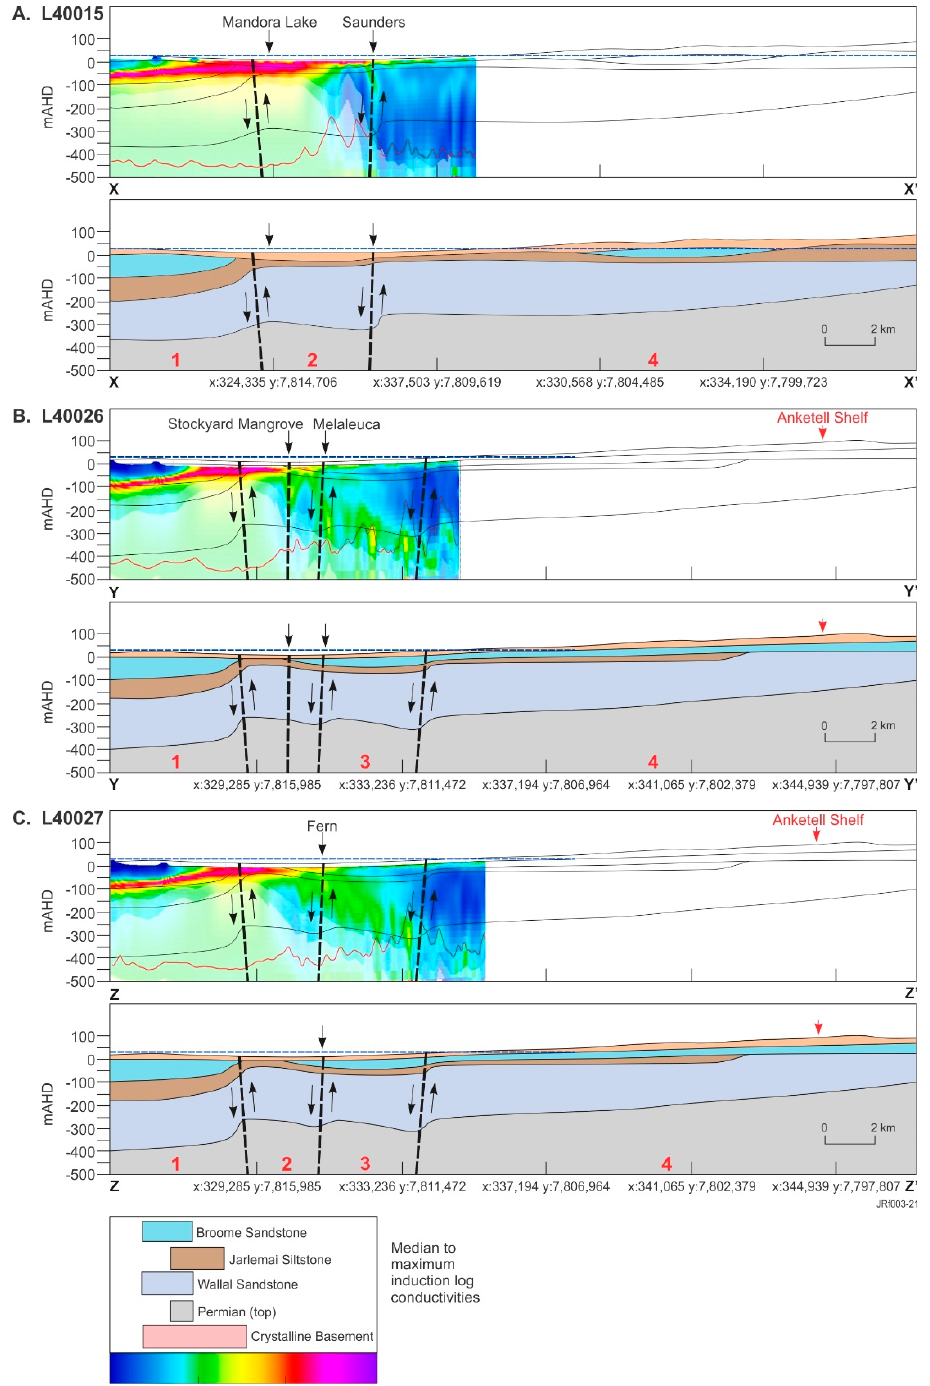
Figure 5. TEMPEST AEM 1D spatially constrained inversion (SCI) pseudo-colored conductivity depth sections (2020) for flight lines ( A ) L40015, ( B ) L40026 and ( C ) L40027 (west to east; see Figure 4 for location) (grey shading represents depth of investigation (DOI), and red linework, the 1D AEM inversion error; to the left, conductivity depth sections are superimposed on respective northwest trending geological cross-sections (X-X’, Y-Y’ and Z-Z’; see Figure 3F), extracted from a 3D geological model and presented in greyscale; geological faults are displayed as black dashed lines with arrows denoting the direction of movement; numbers in red on geological sections represent major interpretation domains discussed in the text; blue dashed lines show the estimated Wallal Sandstone aquifer hydraulic head and the geology key is shown in relation to the AEM SCI scale (Note: Conductivity key induction log conductivities are from [60], the Callawa Fm. (Cretaceous) is not shown but is coeval with the Broome Sandstone and displays a similar data range).